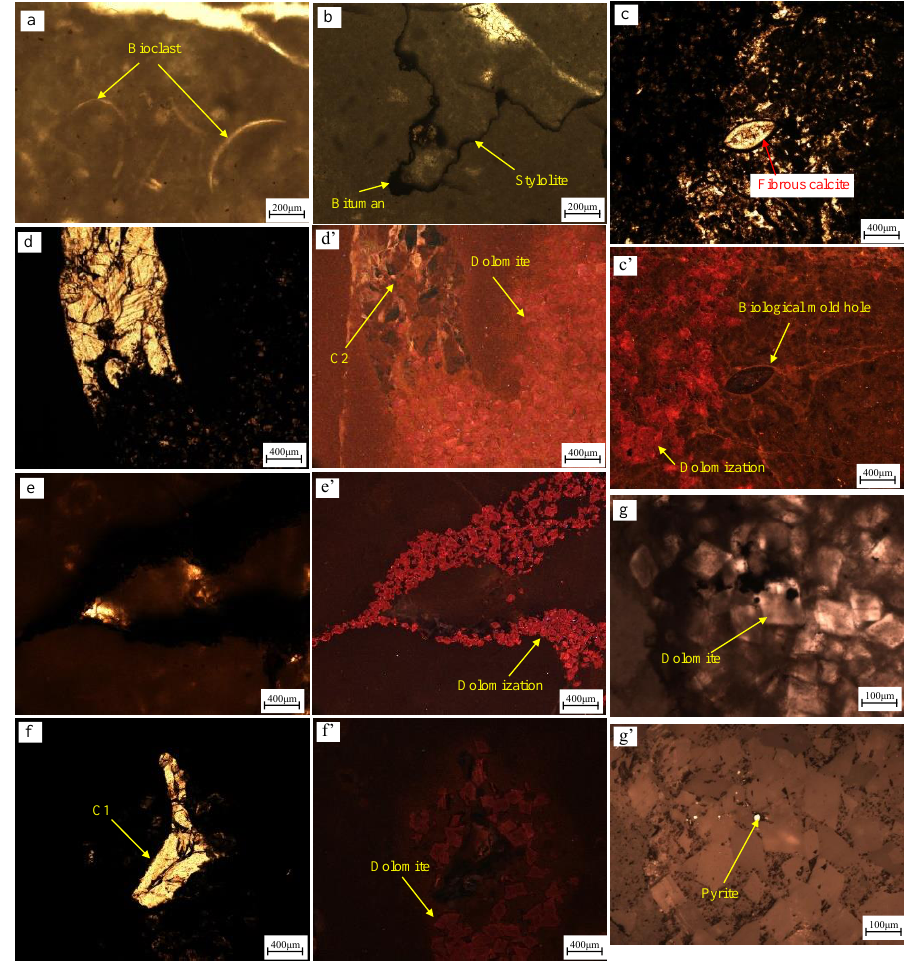
Figure 3. Diagenetic characteristics of the Ordovician reservoirs in the Shunbei area. The photomicrographs a, b, c, d, e, f, and g were taken under transmitted light, the photomicrographs c’, d’, e’, and f’ were taken under cathodoluminescence, and the photomicrograph g’ was taken under reflected light. ( a ) SHBL1 well, O 1 – 2 y , 7633.3 m, bioclastic limestone, bioclastic spathization; ( b ) SHBL1 well, O 1 – 2 y , 7436.95 m, micritic limestone, pressolved stylolite filled with bitumen; ( c , c’ ) SHB52A well, O 2 yj , 7674.75 m, dolomitic micritic limestone, fibrous calcite cement develops along the moldic pore walls; ( d , d’ ) SHBL1 well, O 1 – 2 y , 7430.6 m, dolomitic micritic limestone, dolomitization occurs in calcite cement filled fractures; ( e , e’ ) SHB52A well, O 1 – 2 y , 7782.05 m, micritic limestone, dolomites distributed along a stylolite; ( f , f’ ) SHBL1 well, O 1 – 2 y , 7633.3 m, dolomitic micritic limestone,